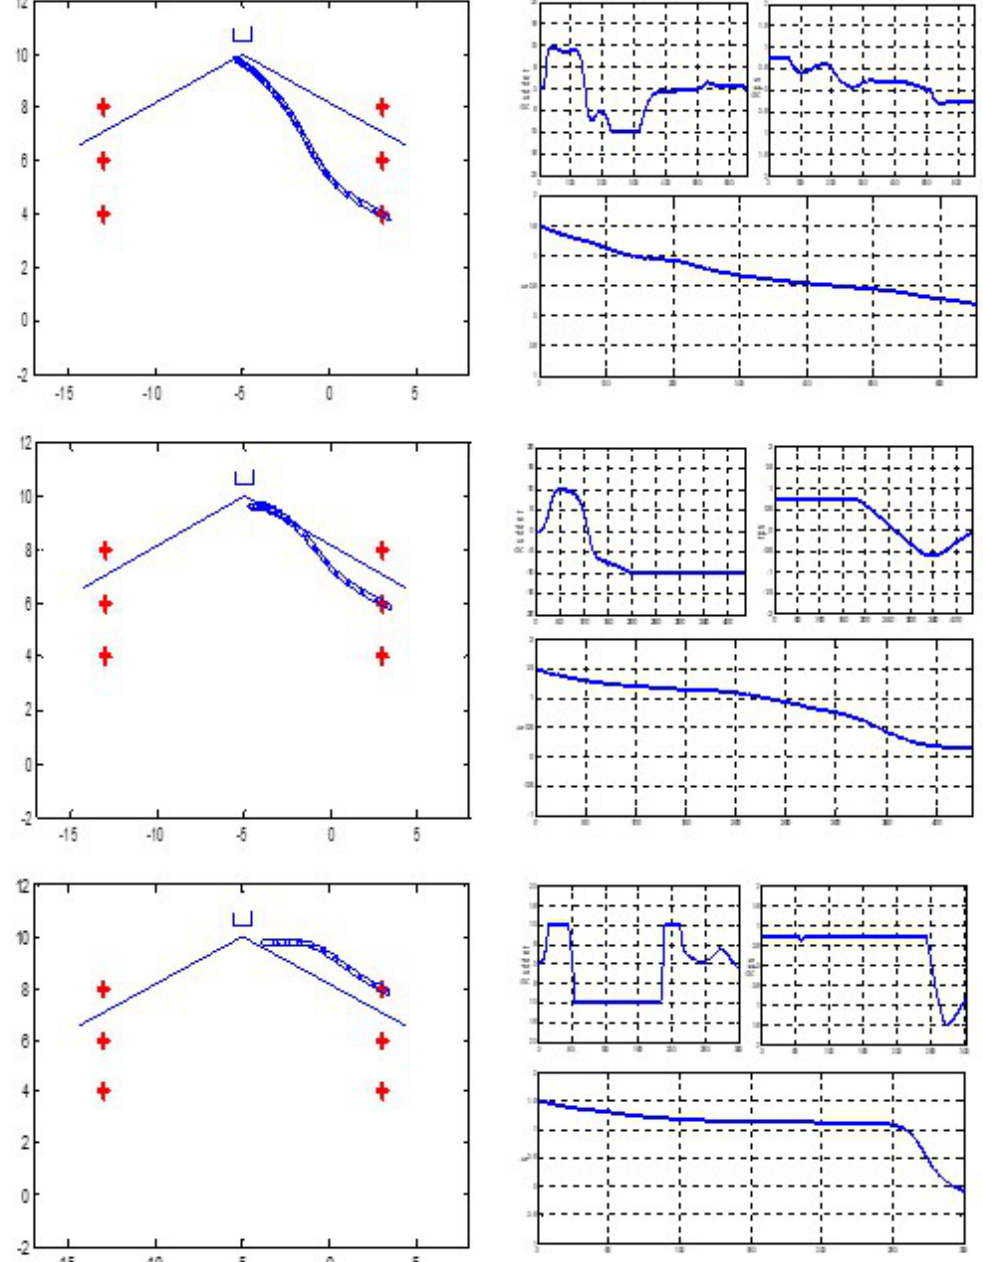
Figure 15. Automatic ship berthing in the different port from the starboard side.